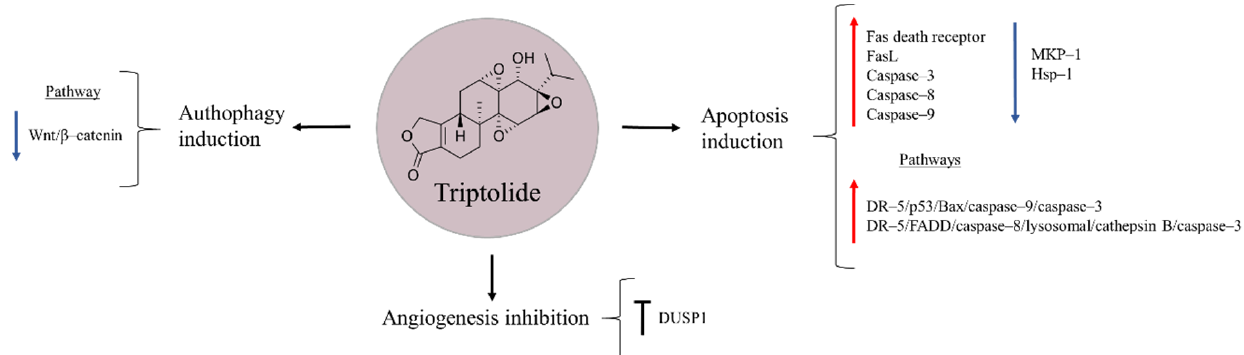
Figure 8. Triptolide in osteosarcoma inhibition.